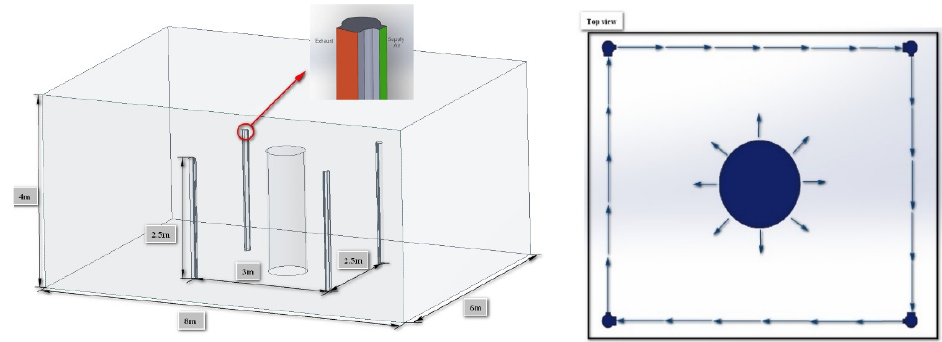
Figure 8. Three-dimensional model of the fluid region.